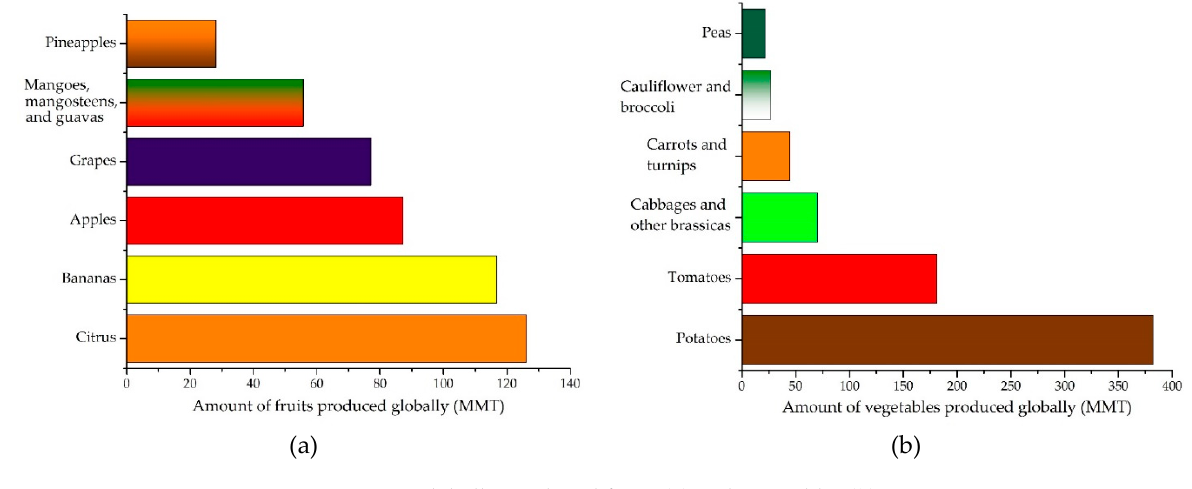
Figure 3. Globally produced fruits ( a ) and vegetables ( b ).